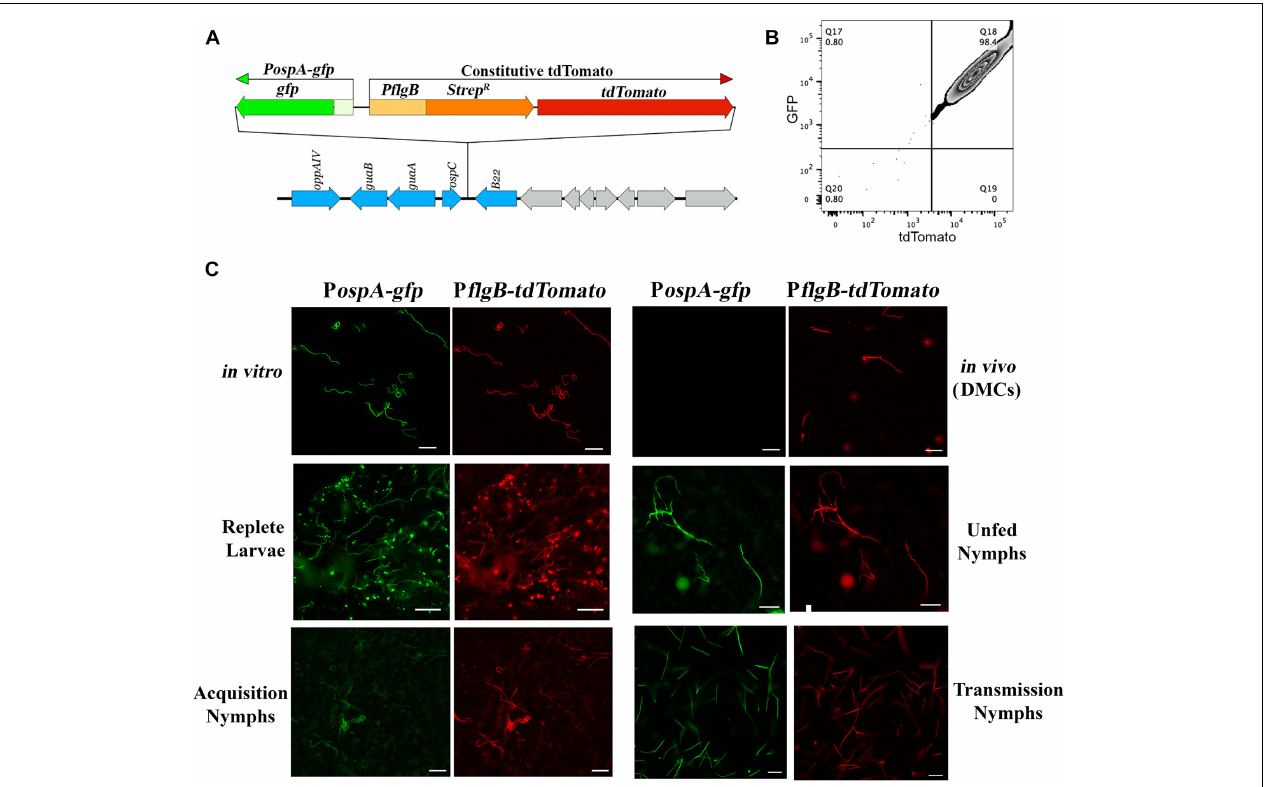
FIGURE 2 | ospA is expressed throughout the entire tick phase of the enzootic cycle. (A) Cartoon depicting the tandem insertion of a P ospA-gfp /P flgB tdTomato “dual color” cassette into the cp26 bbb21-22 intergenic region (Kawabata et al., 2004); the resulting B. burgdorferi strain was designated BbP1981. The upstream region used to monitor expression of ospA (P ospA ) includes sequences required for RpoS-mediated repression of the ospA in mammals (Grove et al., 2017). (B) Representative quad-plots for temperature-shifted in vitro P ospA-gfp +/tdTomato+ double-positive spirochetes. Numbers indicate the percentage of positive events in each quadrant. (C) Representative epifluorescence images of the P ospA-gfp /P flgB-tdTomato dual color strain (BbP1981) following temperature-shift at 37 ◦ C in vitro ; cultivation in DMCs; in I. scapularis larvae fed to repletion on BbP1981-infected C3H/HeJ mice; in unfed nymphs; in BbP1981-infected nymphs fed for 72–96 h on a naïve C3H/HeJ mice (Transmission Nymphs); and in naïve nymphs fed for ∼ 36–48 h on C3H/HeJ mice 4 weeks post-infection (Acquisition Nymphs). Scale bar, 20 µ